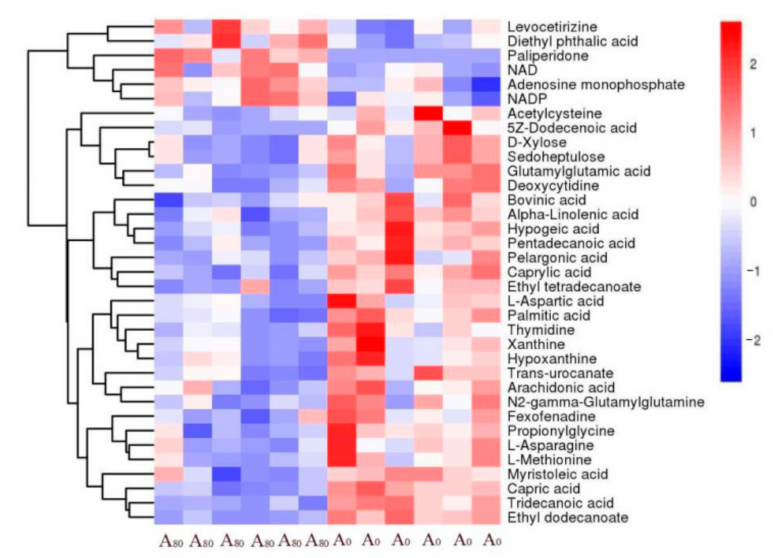
Figure 5. Heat map demonstrating the changes in concentration of metabolites with (A 80 ) and without (A 0 ) supplementary Astralagus membranaceus (AMT). The y -axis shows the 35 identified metabolites and the x -axis lists the AMT treatments. Red color squires represent high concentrations of metabolites, and blue color squires represent low concentrations of